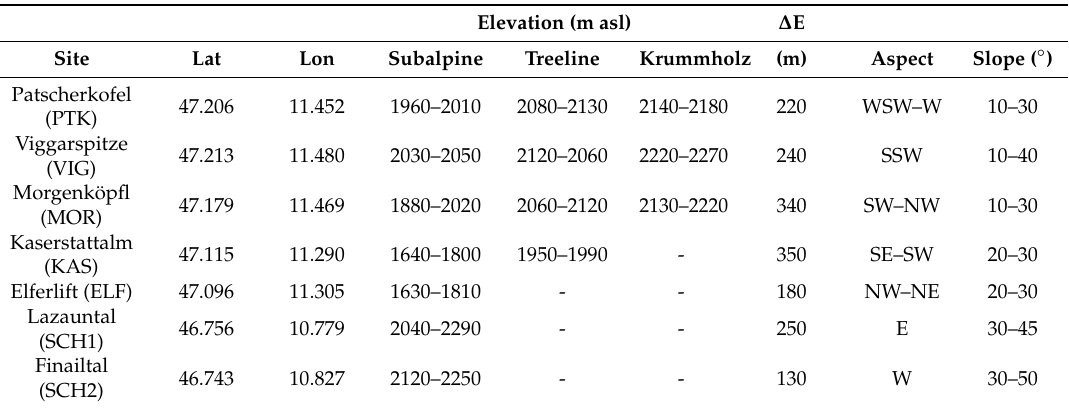
Table 1. Site characteristics of selected stands along elevational transects in the Central European Alps. Geographic coordinates are given for the lowest site at each sampled transect (Lat = latitude; Lon = longitude; ∆ E = elevational di ff erence between highest and lowest stand).